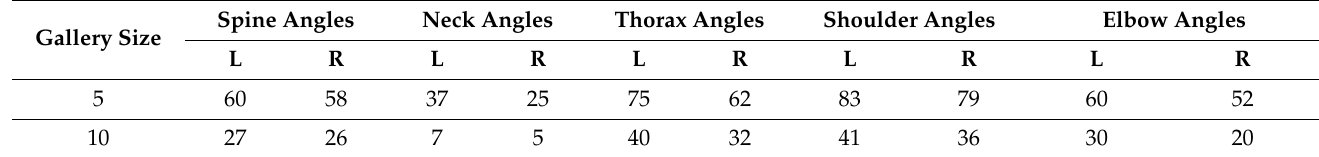
Table 3. Gait classifier recognition rates using upper-body angle trajectories.